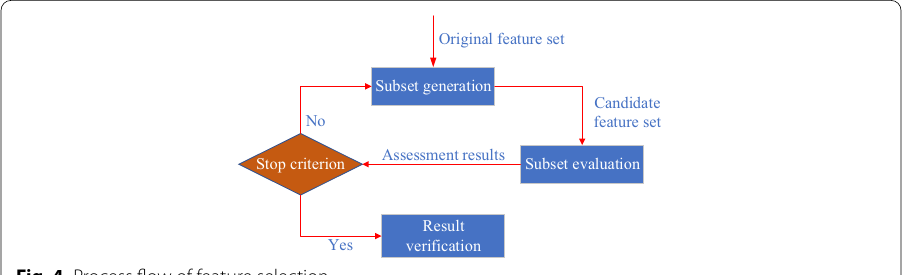
Fig. 4 Process flow of feature